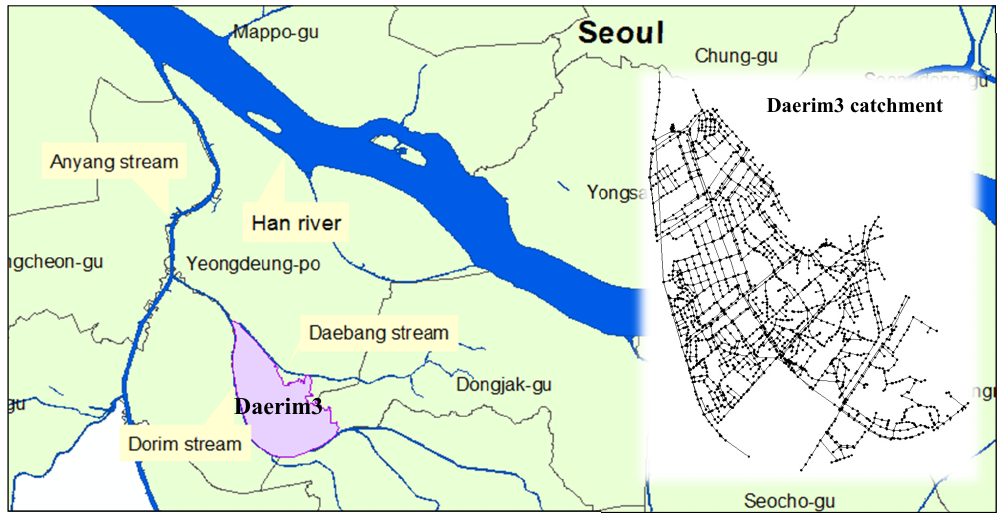
Figure 3. Layout of Daerim3 catchment in Seoul. Figure 3 . Layout of Daerim3 catchment in Seoul.